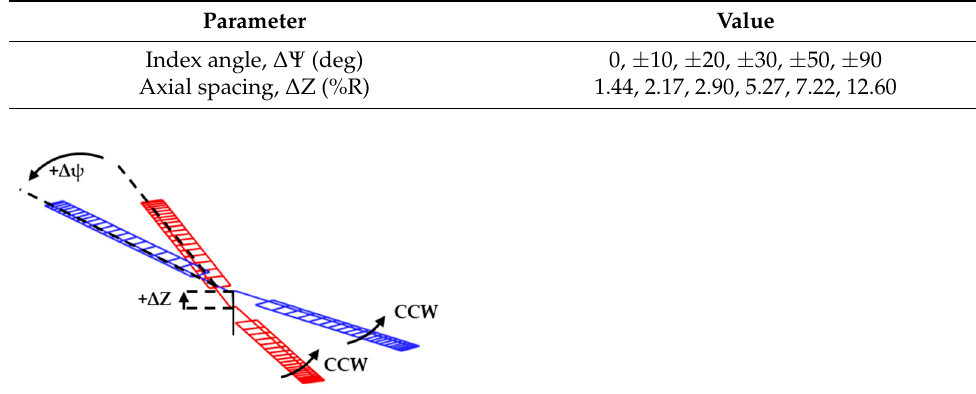
Figure 7. CAMRAD II model for a coaxial co-rotating rotor in hover.